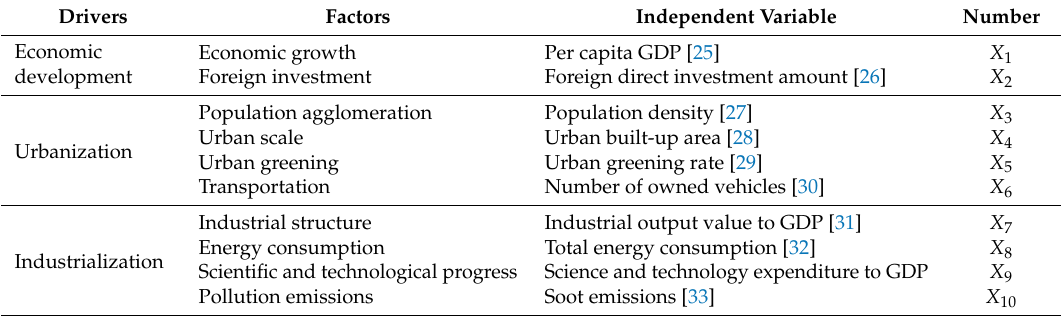
Table 1. Social and economic factors affecting PM 2.5 concentration in Chinese